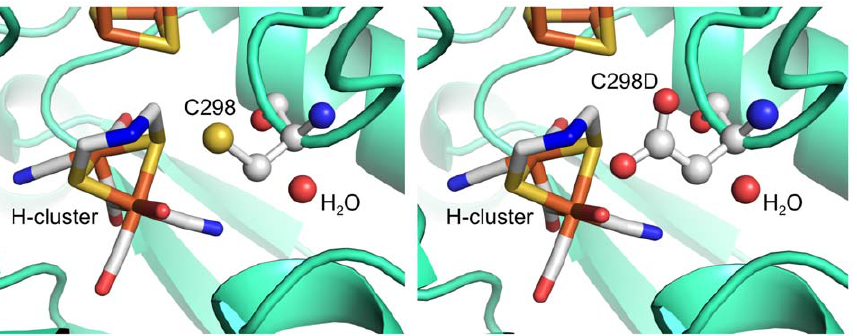
Figure 7. Model of CaHydA structure illustrating C298 role in catalysis. C298 mediates proton transfer from a molecule of structural water to the nitrogen atom of the active site (left). Aspartic acid can replace cysteine because of similar steric hindrance (right) and protonability, allowing both hydrogen evolution and uptake.